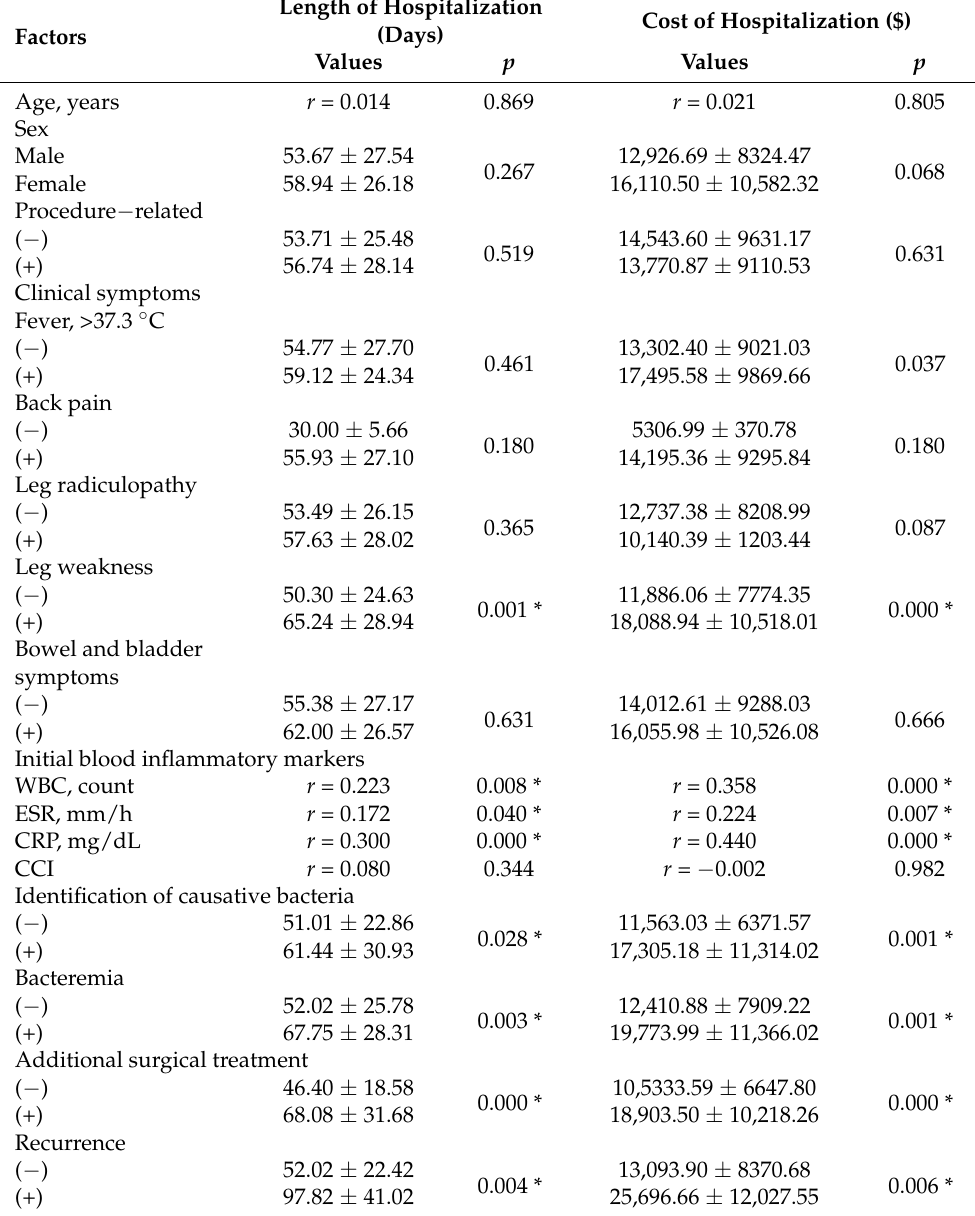
Table 3. Clinical factors associated with medical burden. WBC, white blood cell; ESR, erythrocyte sedimentation ratio (normal range < 20 mm/h); CRP, C-reactive protein (normal range < 0.5 mg/dL); CCI, Charlson comorbidity index; MR, magnetic resonance, $, US dollar (mean exchange rate